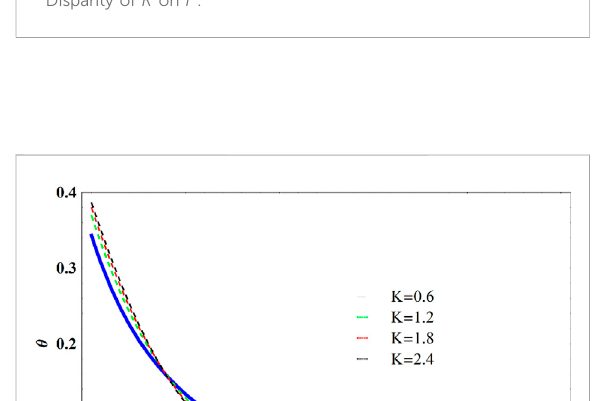
FIGURE 5 Disparity of K on f ′ .